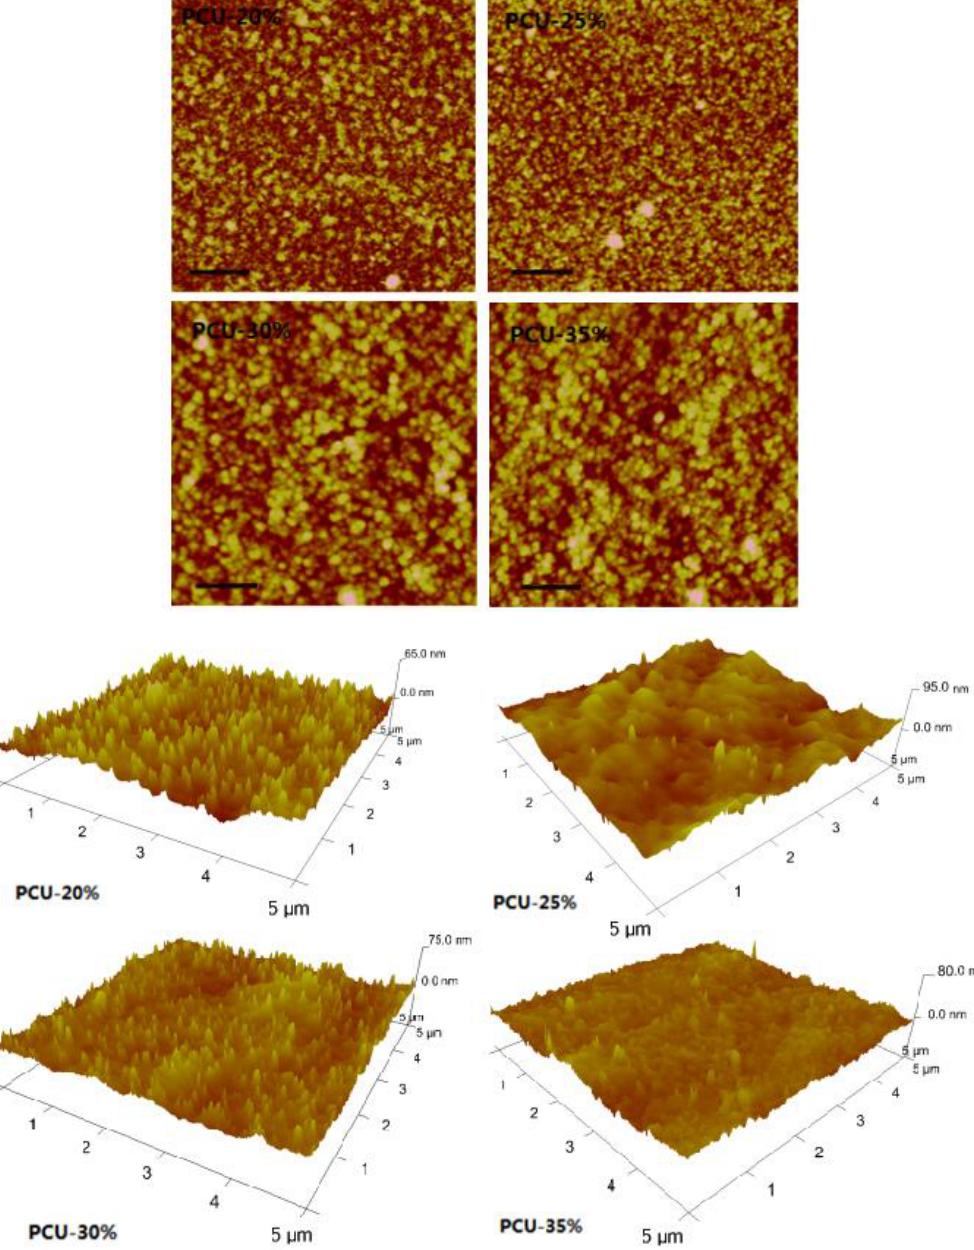
Figure 3. Atomic force microscopy images of surface relief (5 × 5 μm) and phase images (500 × 500 nm) of the films. The scan bar on the images is 100 nm.